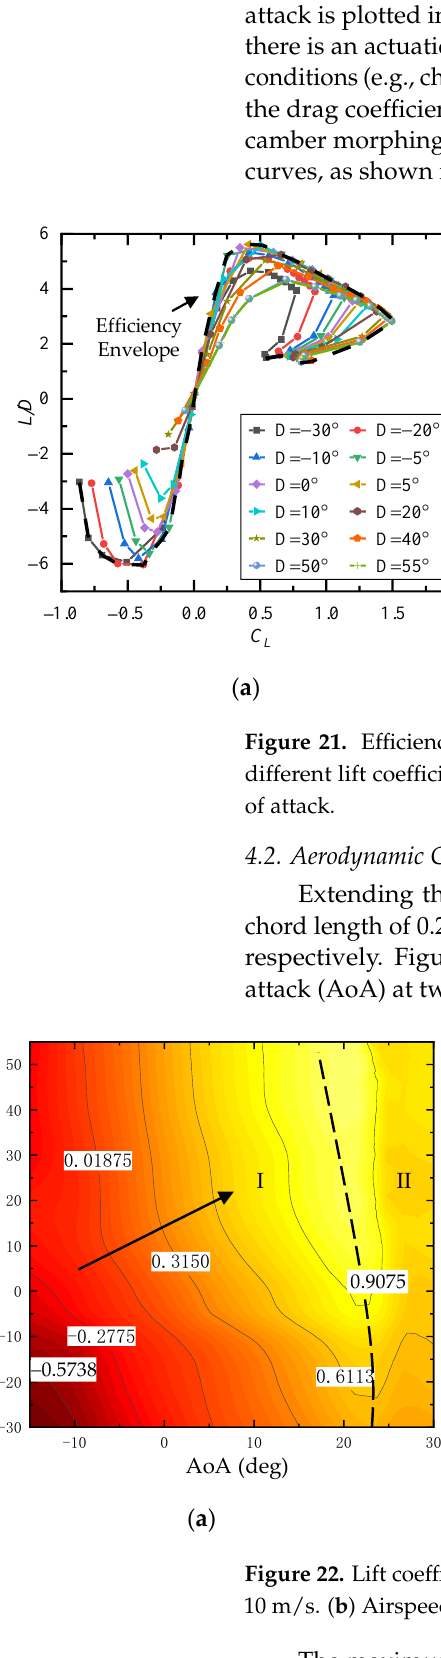
line. The dashed line divides the contour into two regions, left and right, marked as